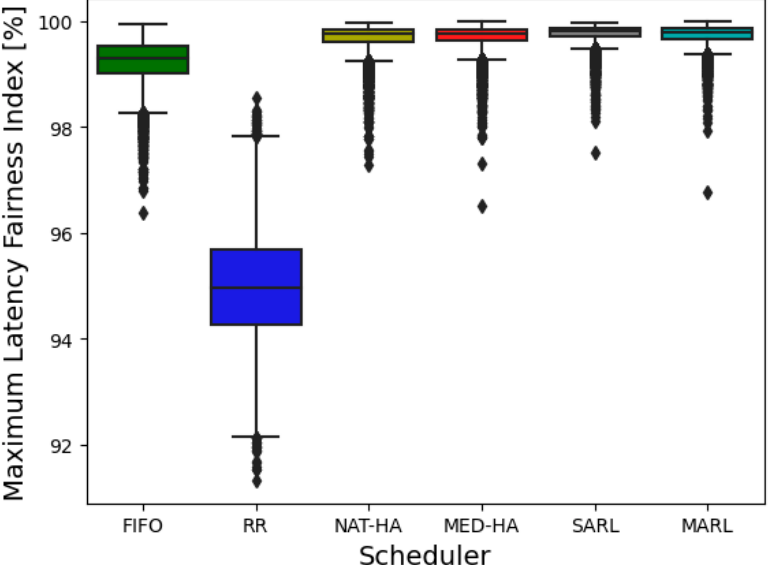
Figure 21. Box plot of maximum latency fairness index per scheduler from 10,000 episodes in topology 2 with the random flow. Table 13. Maximum latency fairness in topology 2 with the random flow.